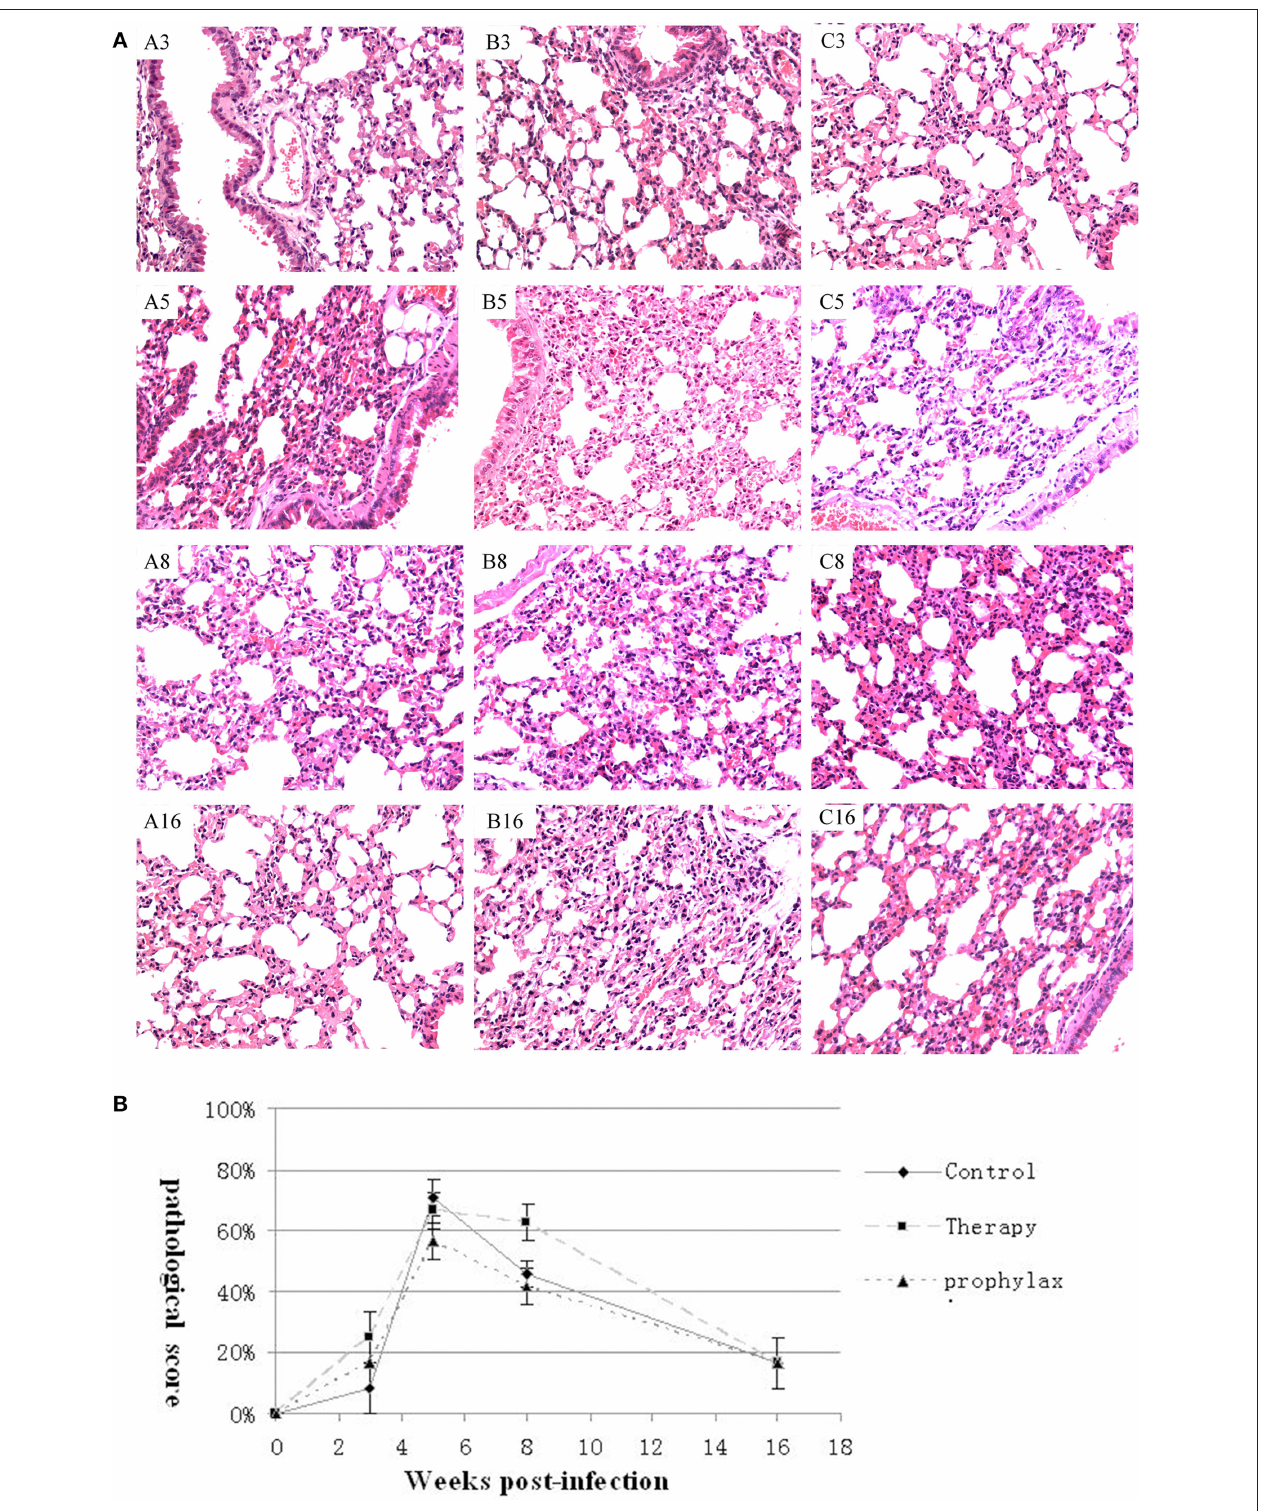
FIGURE 4 | Pathology of the lung. (A) Histopathology of the lungs at weeks 3, 5, 8, and 16 weeks of representative mice in the (A3–A16) control, (B3–B16) prophylaxis, and (C3–C16) therapy groups (200 × ). (B) Pathological lesion scores in the lung of mice in the control, therapy and prophylaxis groups at weeks 3, 5, 8, and 16. SEMs are plotted ( P >